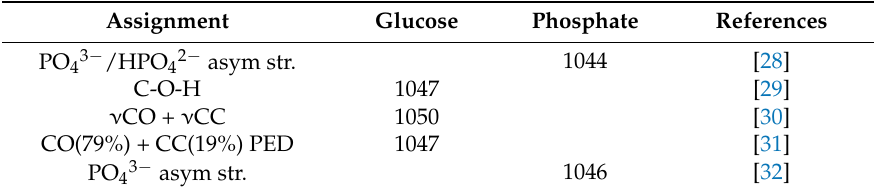
Table 3. IR data (cm − 1 ) concerning vibrations of solid state phosphates and glucose C(6)-O-H. The descriptions of the vibrations in column 1 are those of the authors of respective